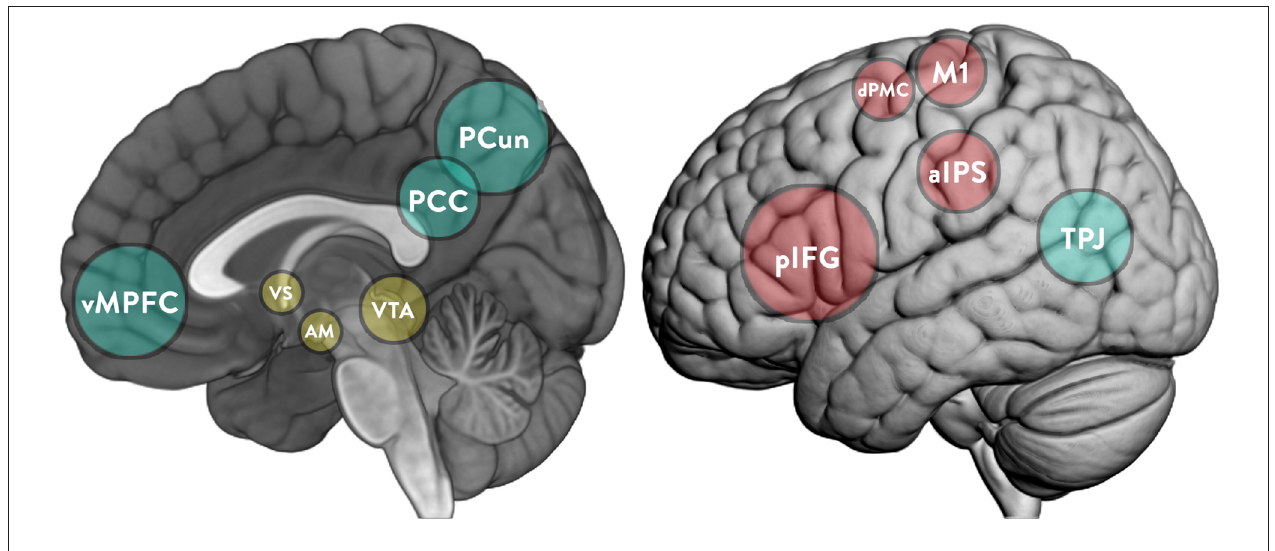
motor cortex; vMPFC, ventromedial part of the prefrontal cortex; PCC, posterior cingulate cortex; PCun, precuneus; TPJ, temporoparietal junction; VS, ventral striatum; VTA, ventral tegmental area; AM,